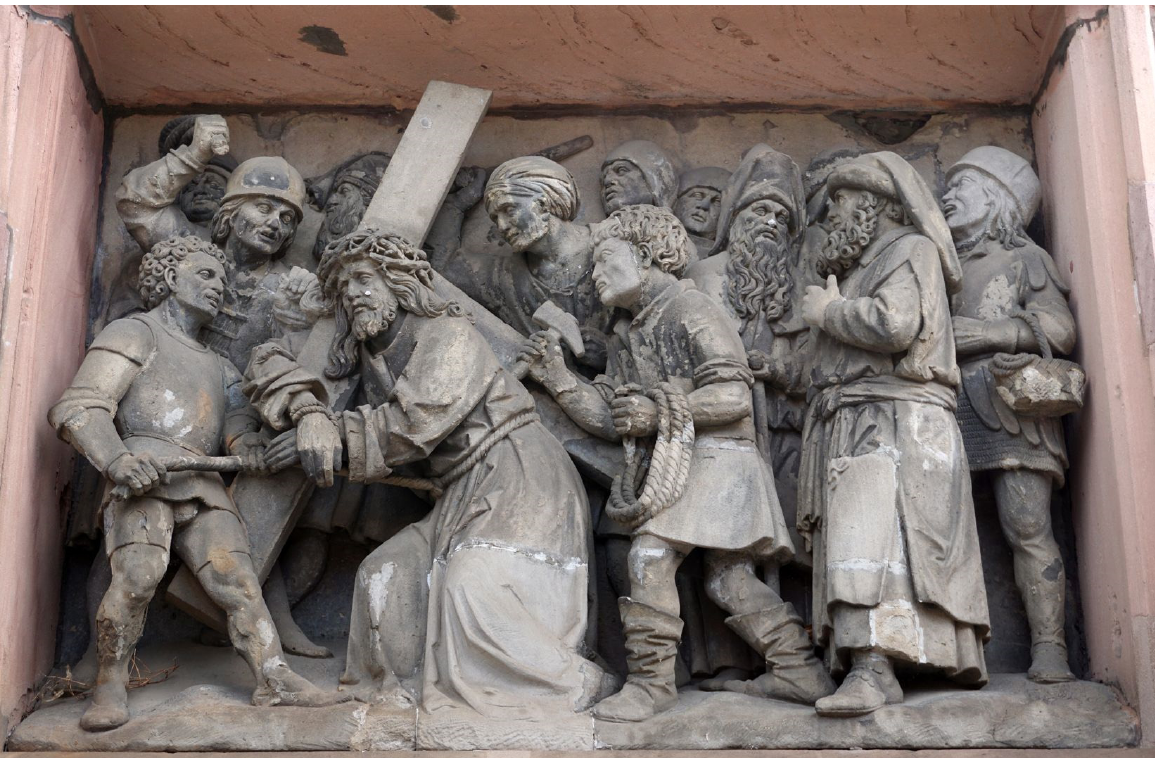
Figure 18. Kraft, Stations of the Cross , Nuremberg, Station Four (Nuremberg, Germanisches National- museum).